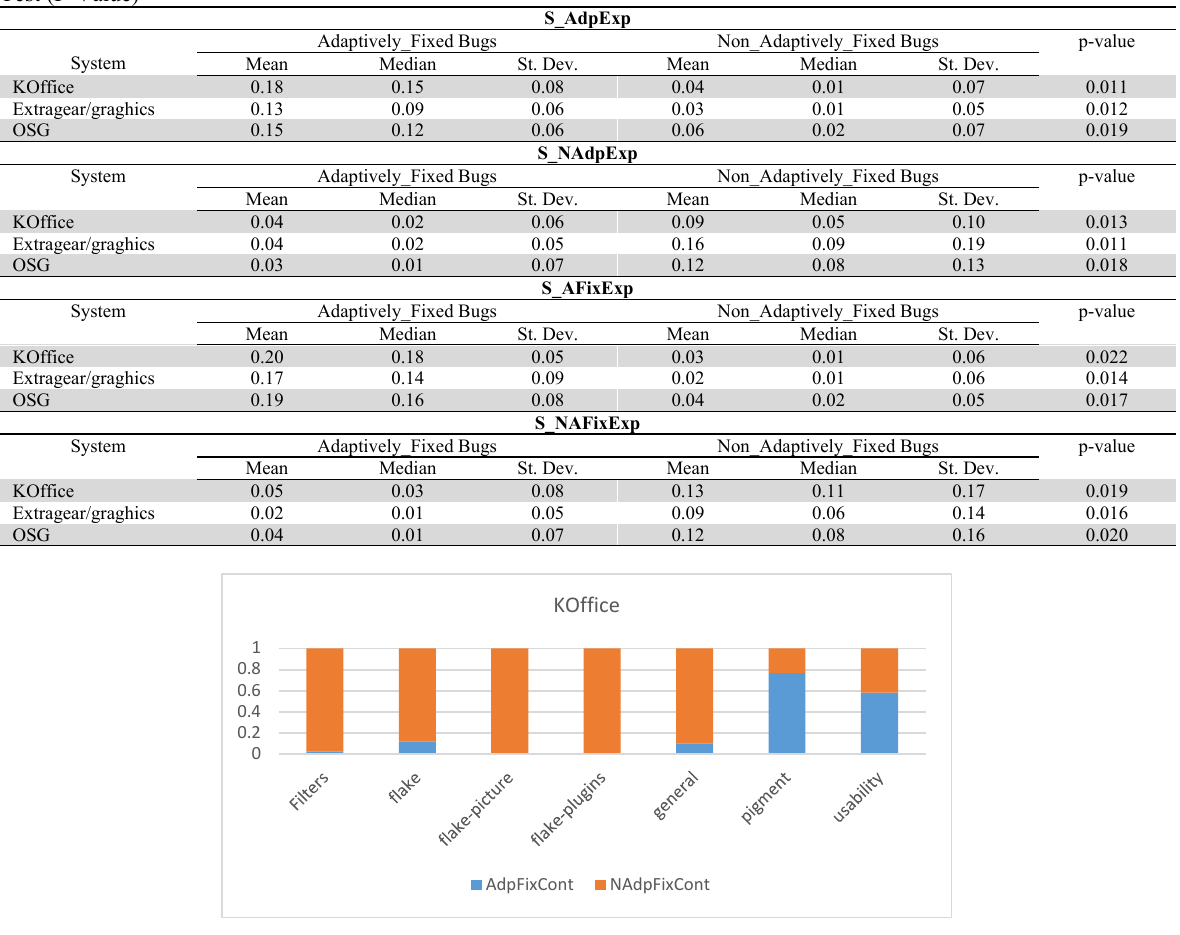
Developer’s Experience In Adaptively_Fixed And Non_Adaptively_Fixed Bugs: Descriptive Statistics And Mann-Whitney Test (P-Value)